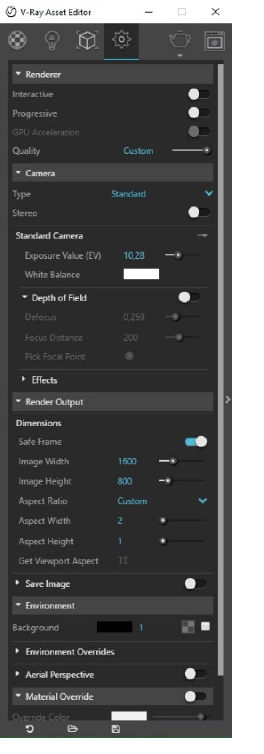
Figure 4. Screenshot of the V-Ray configuration used to produce the images of the Plaza Nueva (The authors, 2017)